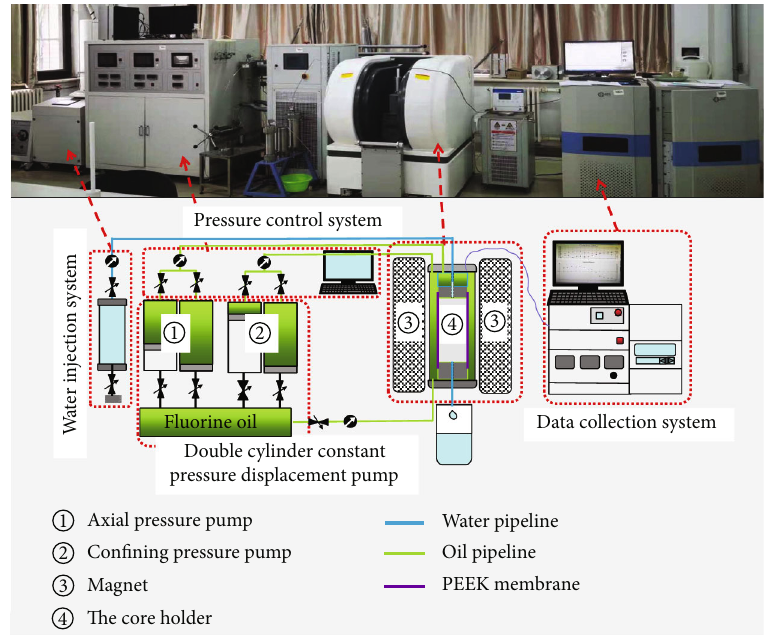
Figure 3: Schematic view of the experimental